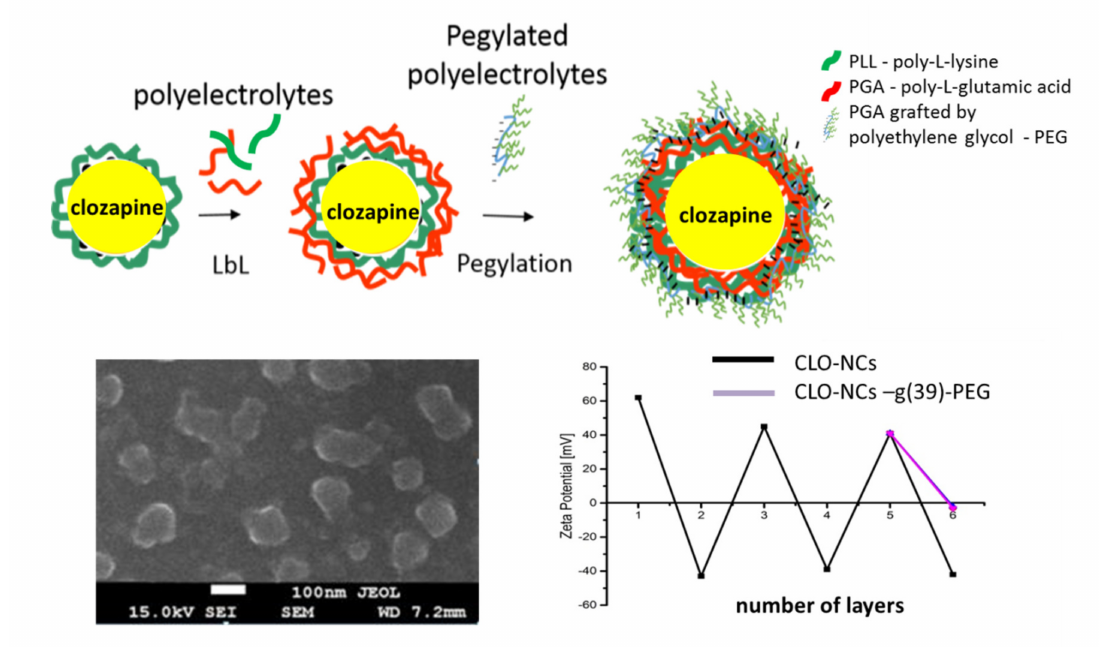
Figure 3. Upper panel —structure of CLO-NCs obtained using LbL technique. Lower panel —SEM micrograph of CLO-NCs VI PGA-g(39)-PEG and zeta potential measurements. Detailed information